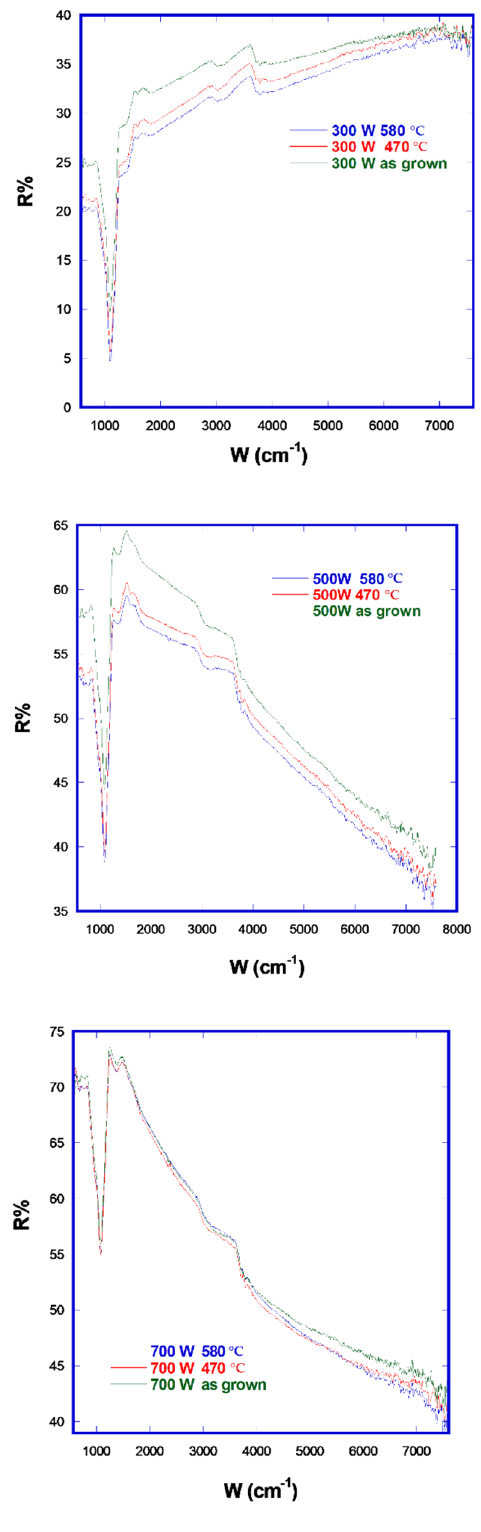
Figure 8. FTIR Reflectance before and after annealing for 300 W, 500 W and 700 W samples. FTIR reflectance in the higher ‐ power film remained almost the same, while in both the other films it decreased after annealing. This took place because the content of W 2 N increases after annealing and the metallic amorphous tungsten nitride clusters crystal ‐ lize, joining to the prevalent W 2 N phase lattice, which has a lower FTIR reflectance with